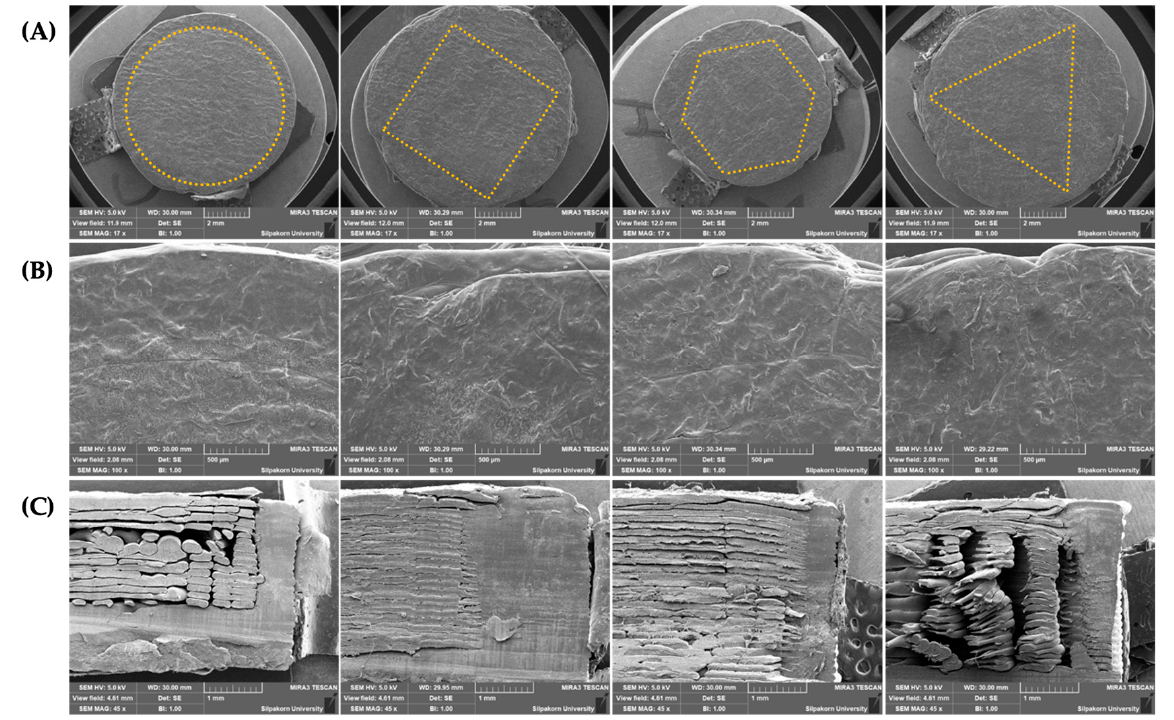
Figure 3. SEM images of FDP ‐ loaded 3D ‐ printed tablets with different internal surface geometries (from left to right: round, square, hexagon, and triangle), showing ( A ) a top view of the whole tablet, ( B ) a close ‐ up view of the top surface, and ( C ) a cross ‐ sectional view.